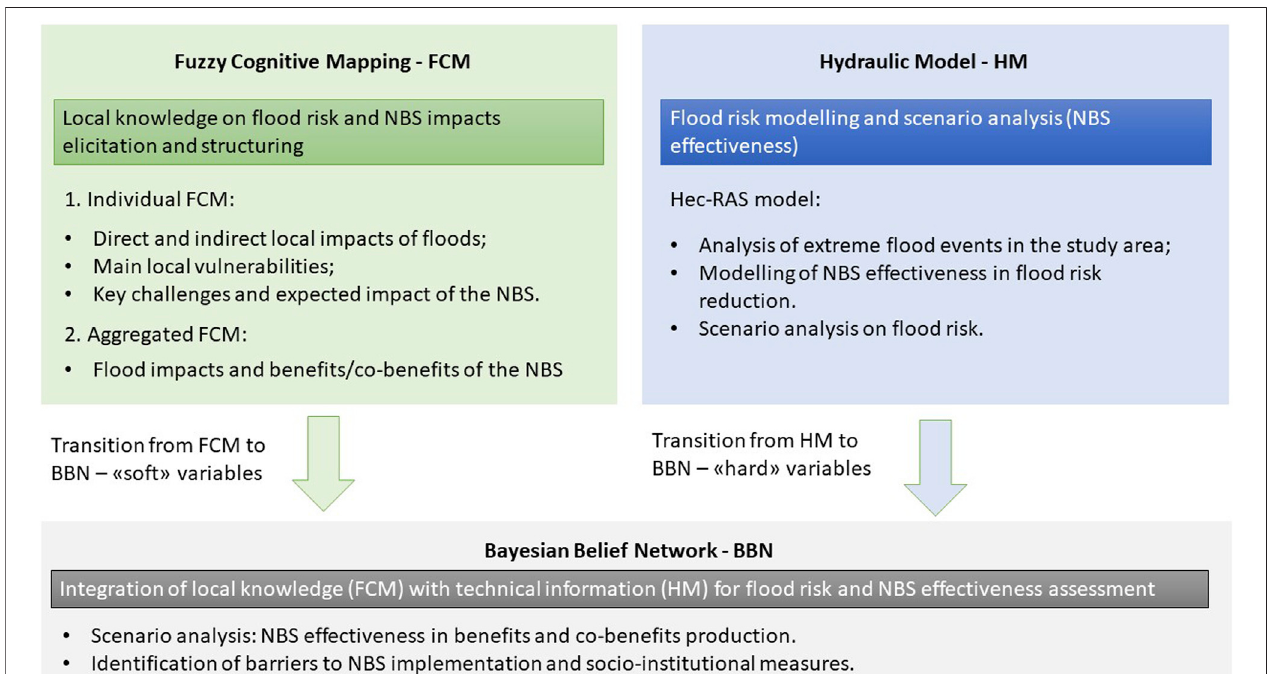
FIGURE 1 | Overview of the adopted